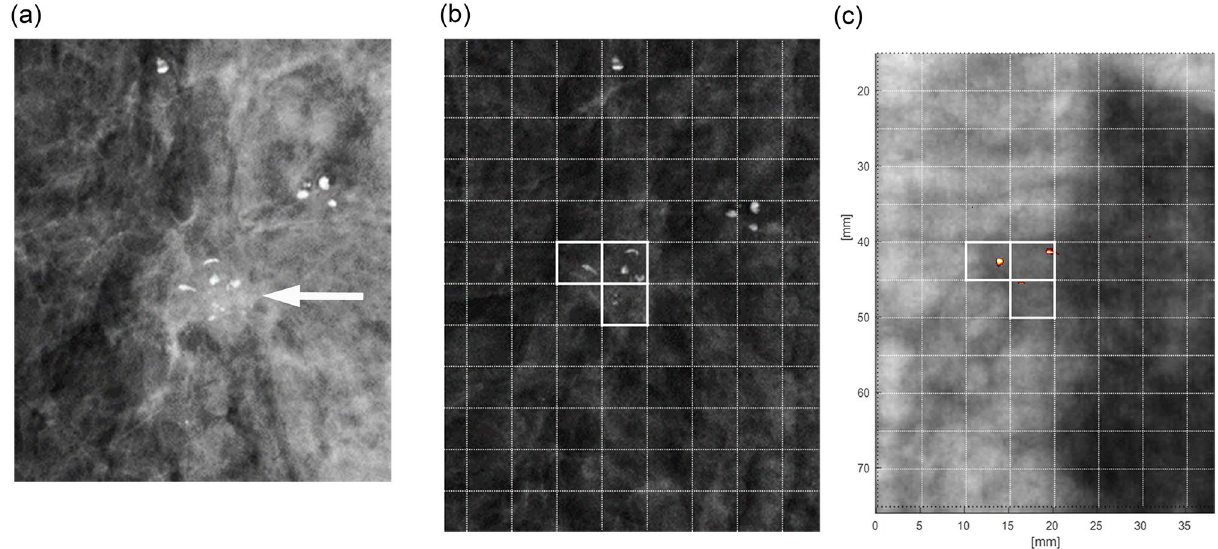
Figure 2. Mammographic and color-encoded US-multifocal Doppler twinkling artifact (MDTA) projection images of an invasive ductal carcinoma in a 64-year-old woman. (a) Specimen magnification mammographic image shows the malignancy as a mass with internal calcifications (arrow). Other diffuse calcifications at the right breast were assessed as benign. (b) Consensus-positive cells are shown on the specimen mammographic image (cells outlined in bold). These were marked by using a grid composed of 5-mm cells. (c) A color-encoded 2D projection image along the z-axis using the US-MDTA volume data showed a 100% detection rate for the consensus-positive